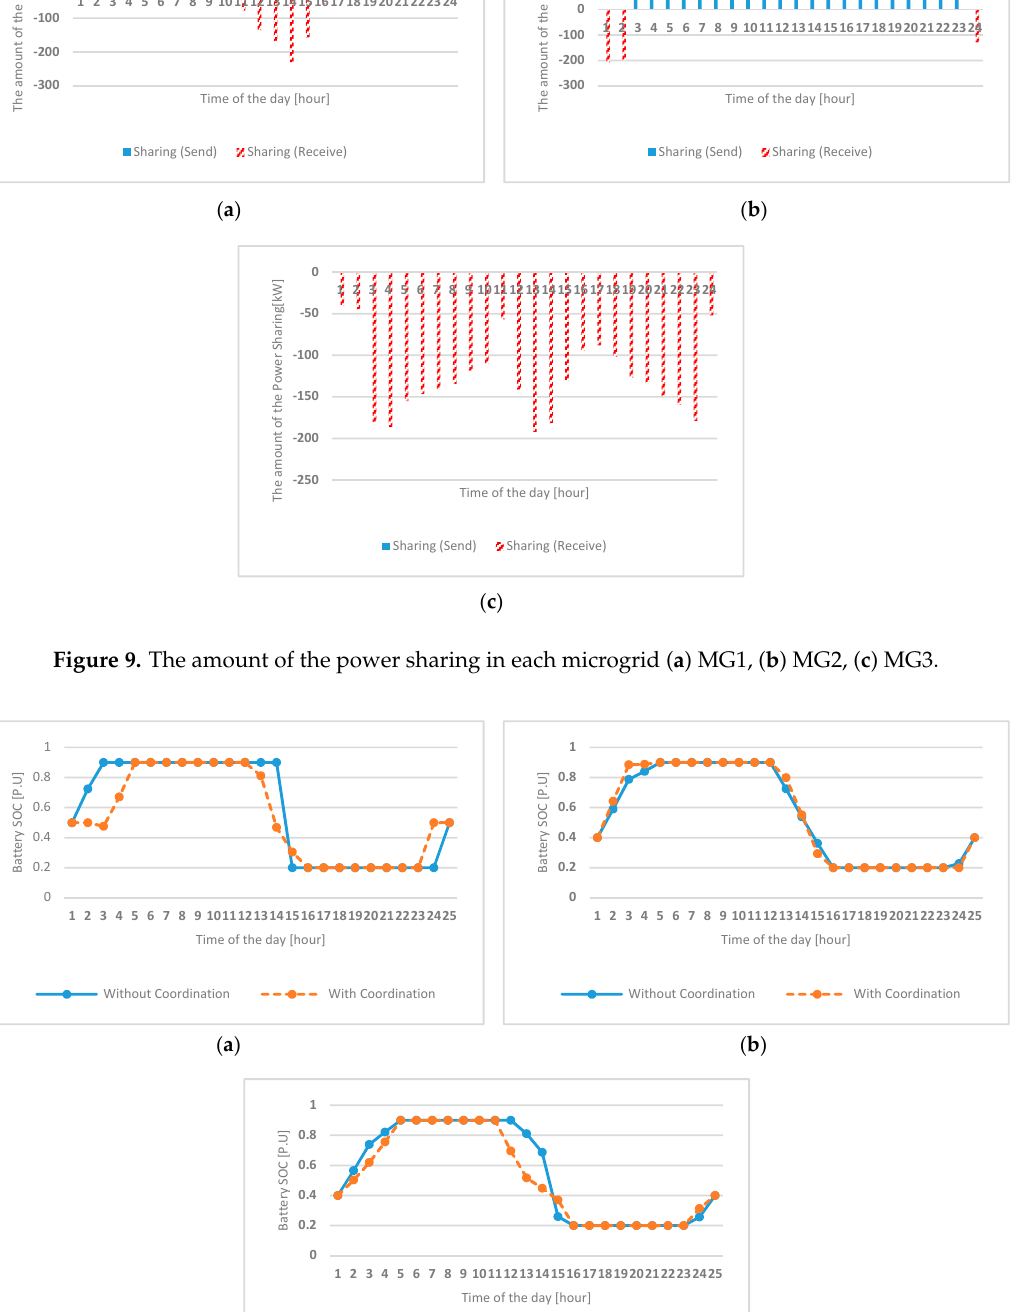
Figure 10. Battery SOC in each microgrid ( a ) MG1, ( b ) MG2, ( c ) MG3.